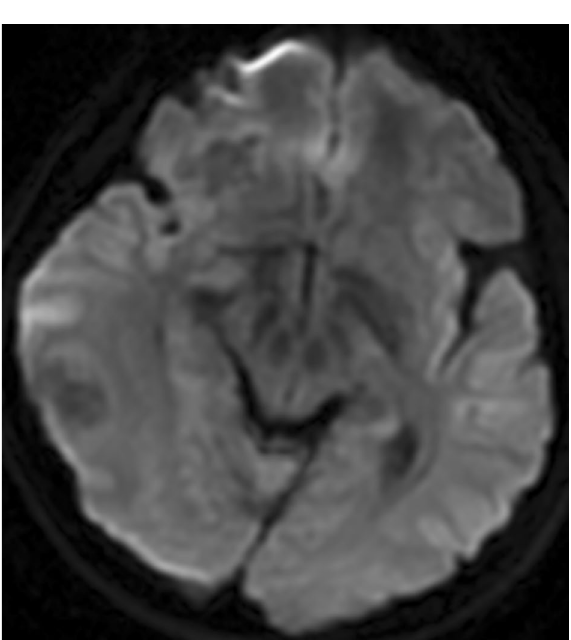
Figure 3. Multiple cerebral lesions were isointense in the T1-weighted image ( a ) and heterogeneously hypointense in the T2-weighted image ( b ) with surrounding perilesional edema. All lesions were enhanced peripherally following injection of contrast ( c ).